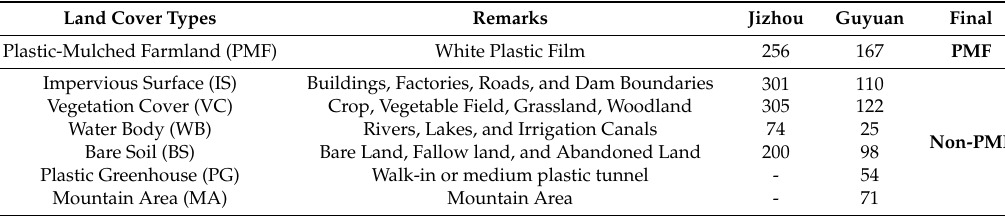
Table 1. The land cover classification scheme in Jizhou and Guyuan.